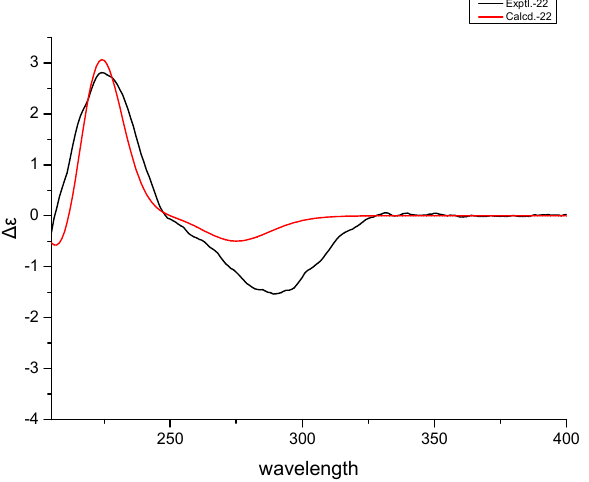
Figure 5. X-ray crystallographic structure of 2 .